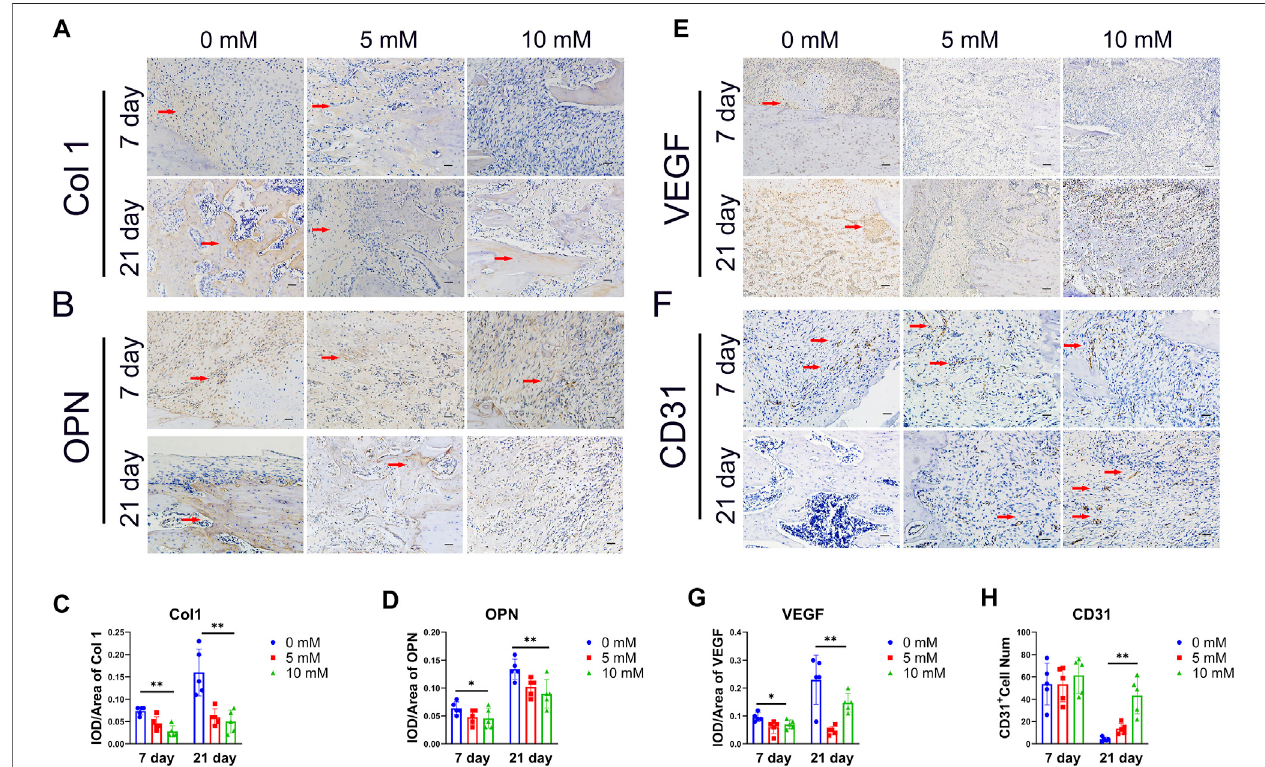
FIGURE2| Histologicalanalysisofthecallus. (A) Representativeimmunohistochemical(IHC)stainimagesoftheosteogenicrelativemarkerofCol1a1andOPNon day 7 and day 28.(× 200, scale bar 200 μ m). (B) IHC scores of Col1a1 and OPN were quanti fi ed. (C) Angiogenesis markers VEGF and CD31 were detected by IHC.(× 200, scale bar 200 μ m) and (D) quanti fi ed by ImageJ. The CD31-positive cells are indicated by arrows, and Col 1, OPN and VEGF-positive regions are indicated by arrows. The data in the fi gures represent the averages ± SD. Signi fi cant differences are indicated as * p < 0.05 or ** p < 0.01, t -test, n =